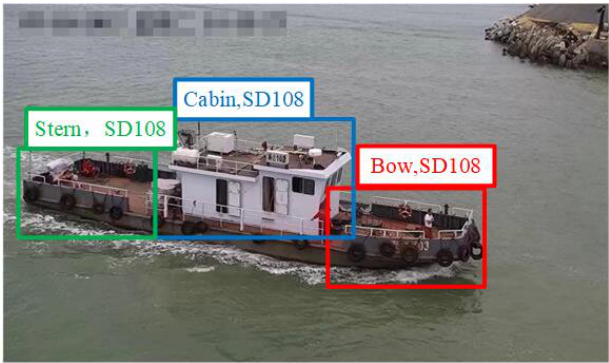
Figure 5. Labels of bow, cabin and